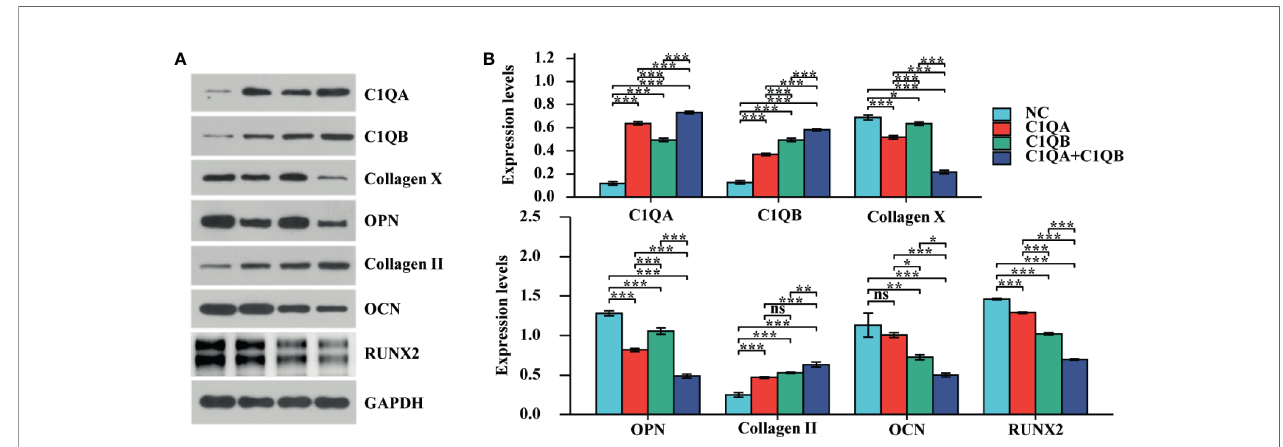
FIGURE 3 | The effect of C1QA and C1QB on chondrocyte mineralization. (A) Western blotting results of the osteogenesis-related proteins (OCN, OPN, RUNX2, Collagen X, and Collagen II). (B) The densitometric analysis of western blotting, *P <0.05, **P < 0.01, ***P < 0.001; ns, not signi fi